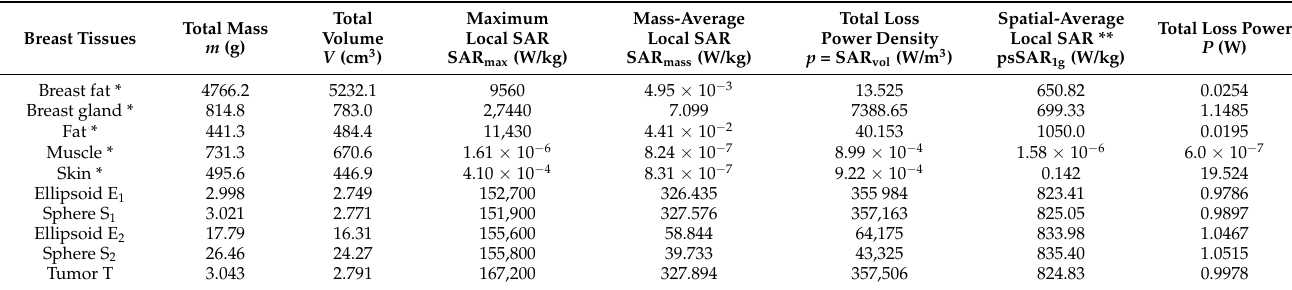
Table 3. Calculated power losses inside breast tissues during RF ablation treatment with frequency f = 100